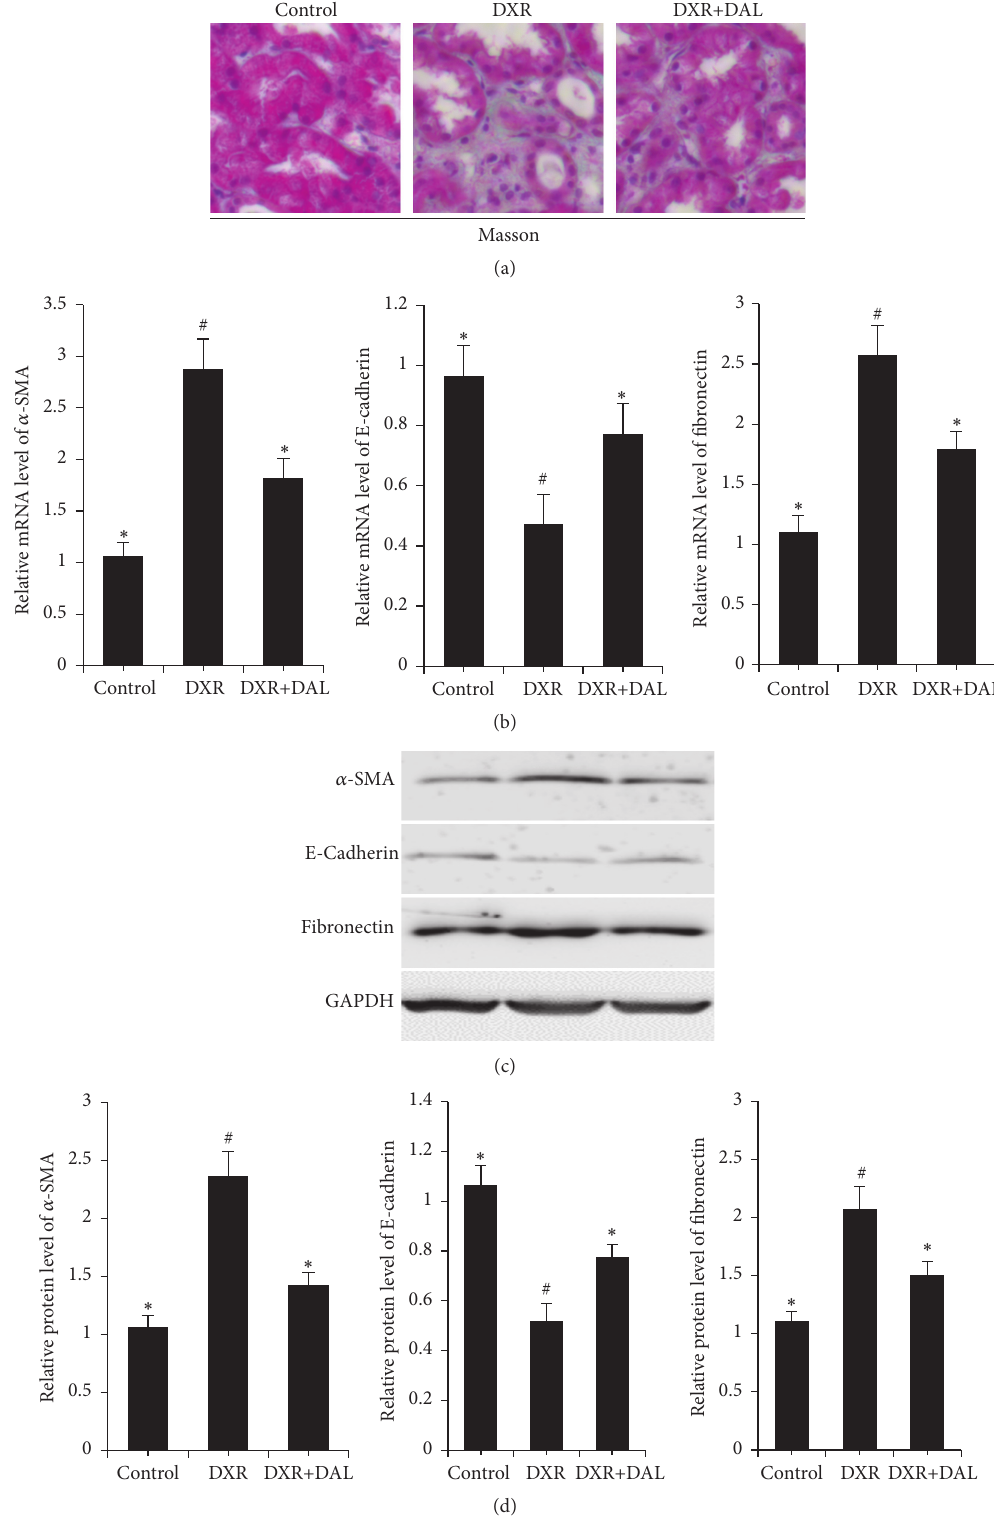
Figure 2: Renal fibrosis at 5 weeks after DXR injection in different groups of mice as indicated. (a) Kidney sections were subjected to Masson- trichrome staining; (b) kidney sections expressed the mRNA of 𝛼 -SMA, and E-cadherin, fibronectin; (c) kidney sections expressed the protein of 𝛼 -SMA, E-cadherin, and fibronectin; (d) the relative protein expression of fibronectin, 𝛼 -SMA, and E-cadherin as seen in the kidney sections. The control and DAL treatment groups are compared with the DXR group. Values are statistically significant at ∗ 𝑝 < 0.05 ; the DXR group is compared with the control group. Values are statistically significant at # 𝑝 < 0.05